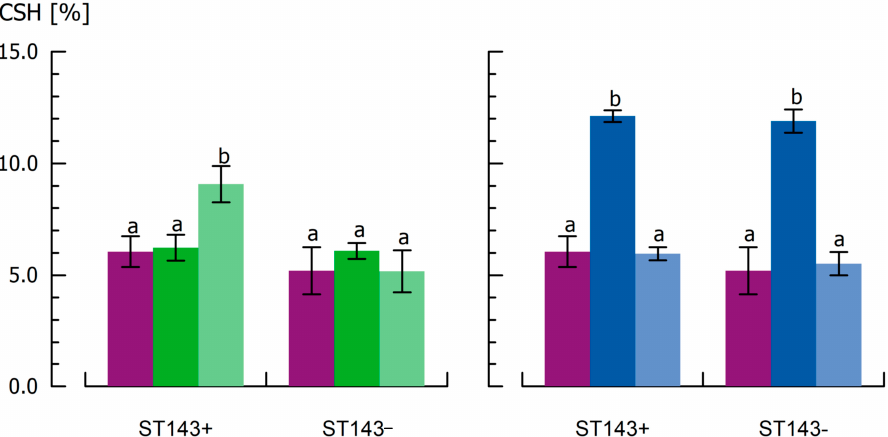
Figure 5. Cell surface hydrophobicity (CSH) of cells from S. thermophilus ST143 + and ST143 − without further treatment (violet); ( left ) after ultrasonication + subsequent cultivation (dark green) and after ultrasonication + subsequent cultivation + second ultrasonication (light green); ( right ) after freeze drying (dark blue) and after freeze drying + subsequent cultivation (light blue). Mean values within the same strain with di ff erent superscripts di ff er significantly ( α =